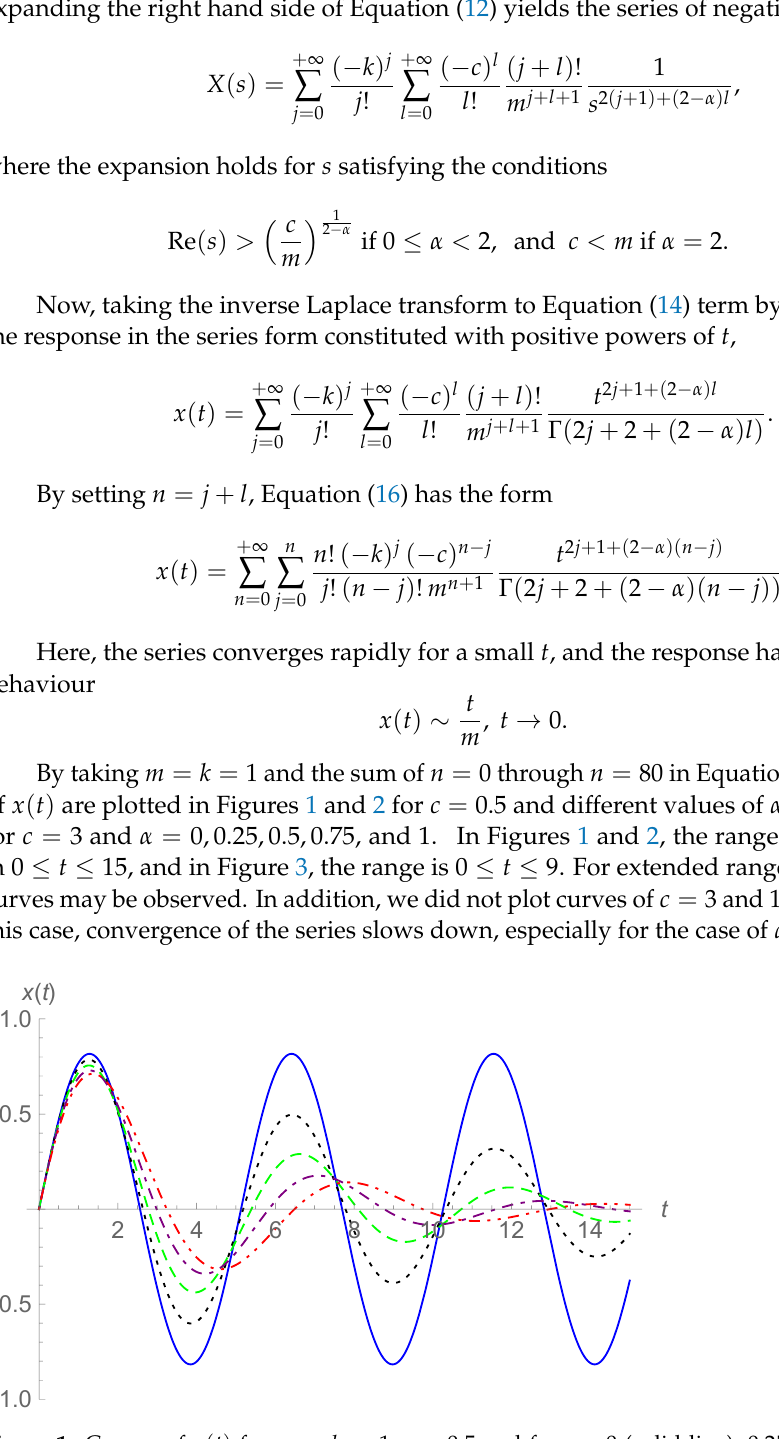
Figure 1. Curves of x ( t ) for m = k = 1, c = 0.5 and for α = 0 (solid line), 0.25 (dotted line), 0.5 (dashed line), 0.75 (dotted-dashed line), and 1 (dotted-dotted-dashed